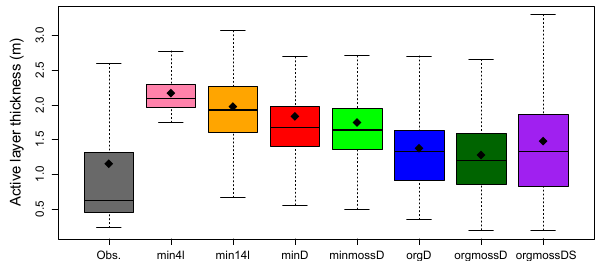
Figure 4. Simulated and observed range of active layer depths for CALM sites (Sect. 2.4.3). Black dots are means, the boxes shows the interquartile range (IQR) and the horizontal line is the median. The whiskers indicate the most extreme data point that is no more than 1.5 times the IQR. Outliers are not shown. Points at which either the simulated or observed active layer was very large (greater than 6m) were removed. The model point for each CALM site is the grid box containing that site.